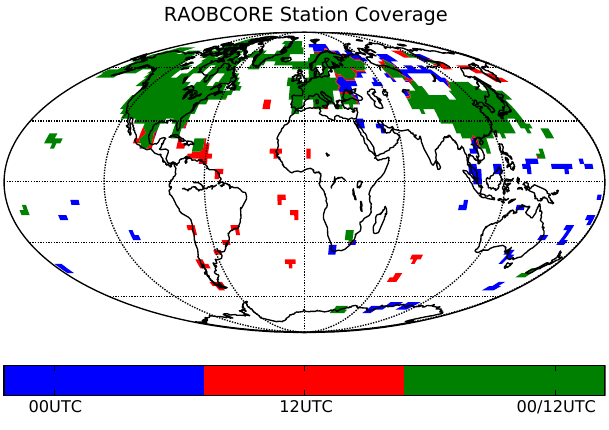
Fig. 3. Global coverage of radiosonde launches used in the RAOB- CORE and RICH datasets. The color code shows whether there are launches at 00UTC (blue), 12:00UTC (red), or at both times (green), in the corresponding 2 . 5 ◦ × 2 . 5 ◦